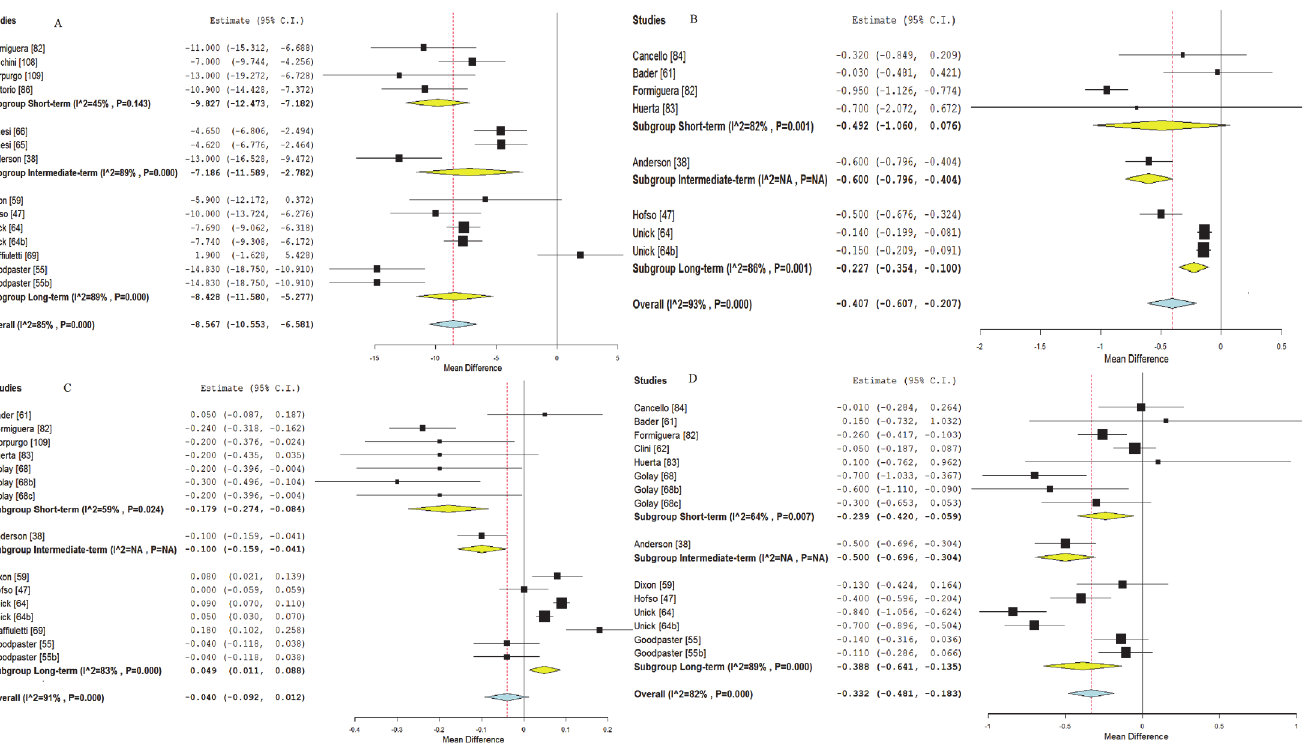
Fig 4. Forest plot of mean systolic blood pressure, LDL cholesterol, HDL cholesterol and triglycerides differences according to the intervention length in class II and III obese individuals. Notes: A (upper corner left): systolic blood pressure; B (upper corner right): LDL cholesterol; C: HDL cholesterol; D: Triglycerides. Letters inserted with the references (b, c, d) represent the different arms of intervention from the same study. A description of each intervention is given in Table 1